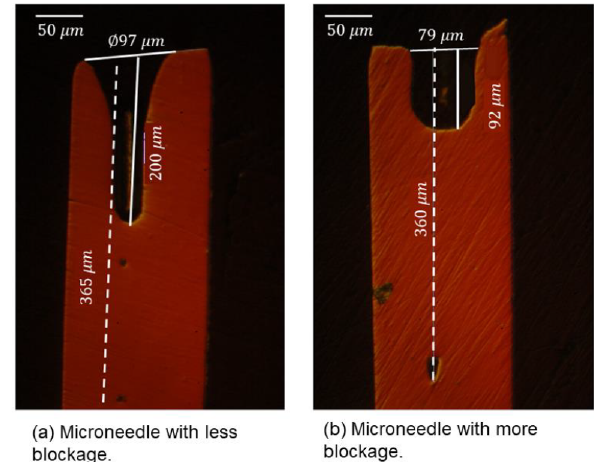
Figure 10: Two Microneedles with laser drilled microholes using seven repetitions of the three 10 µ s pulse group. Needle (a) shows more blockage than needle